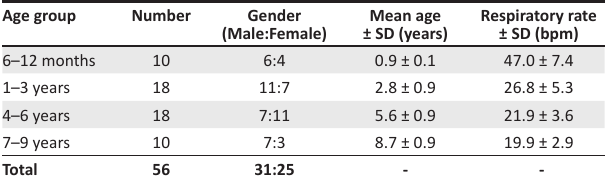
SD, standard deviation; bpm, breaths per minute.